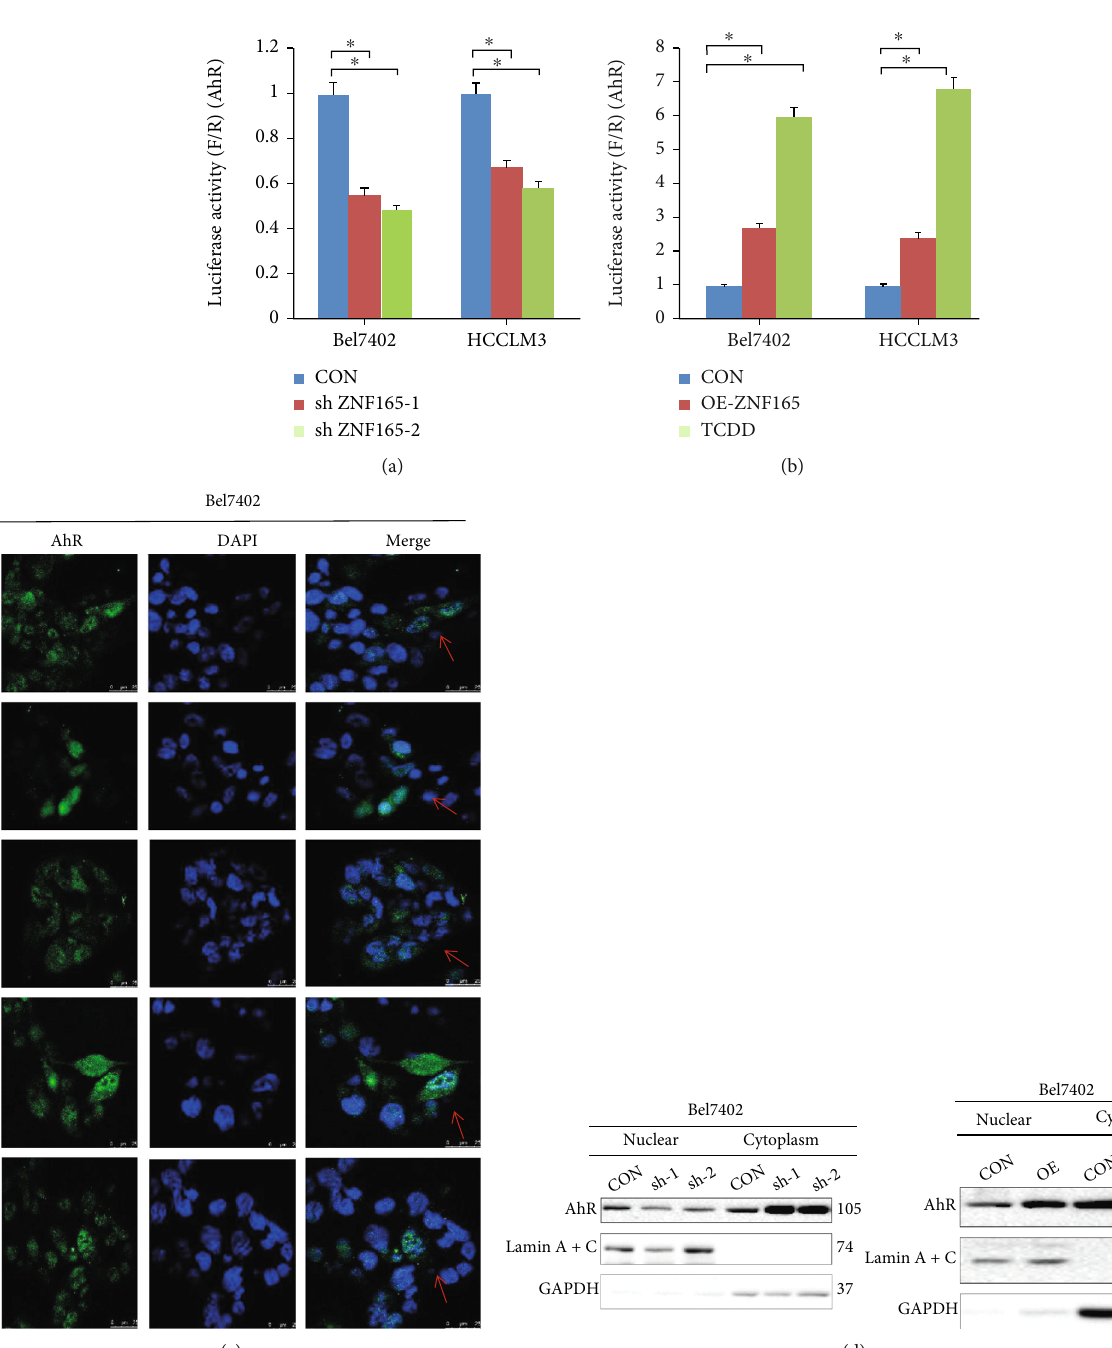
Figure 4: ZNF165 regulates AhR transcriptional activity. (a) ZNF165 overexpression signi fi cantly facilitated the luciferase activity of pGL3- AhR promoter, similar to TCDD a positive control of inducing AhR nuclear translocation. (b) The luciferase activity of the pGL3-AhR promoter was signi fi cantly inhibited by ZNF165 knockdown. (c) The overexpression of ZNF165 increased, while the knockdown of ZNF165 reduced AhR nuclear translocation. As a further con fi rmation, the nuclear and cytoplasm levels of AhR protein were examined in shZNF165-1/2- or OE-ZNF165-transduced cells. (d) After ZNF165 overexpression, AhR levels were signi fi cantly increased in the nucleus and decreased in the cytoplasm. After knocking down of ZNF165, AhR levels were signi fi cantly decreased in the nucleus and increased in the